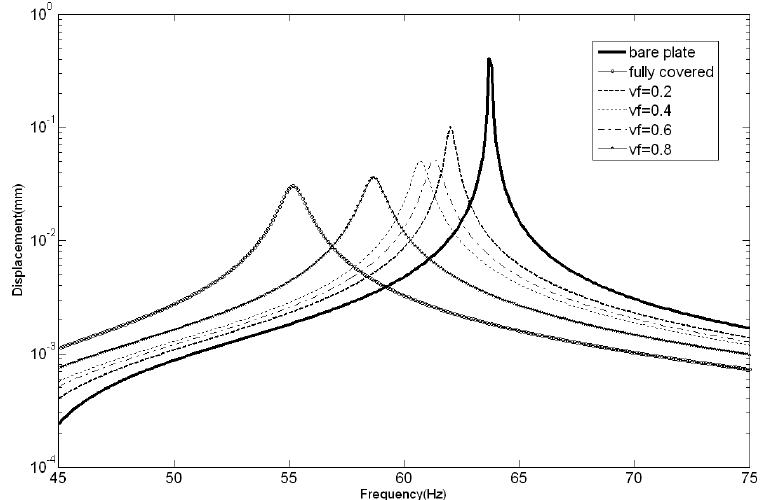
Fig. 28. The second natural frequency.